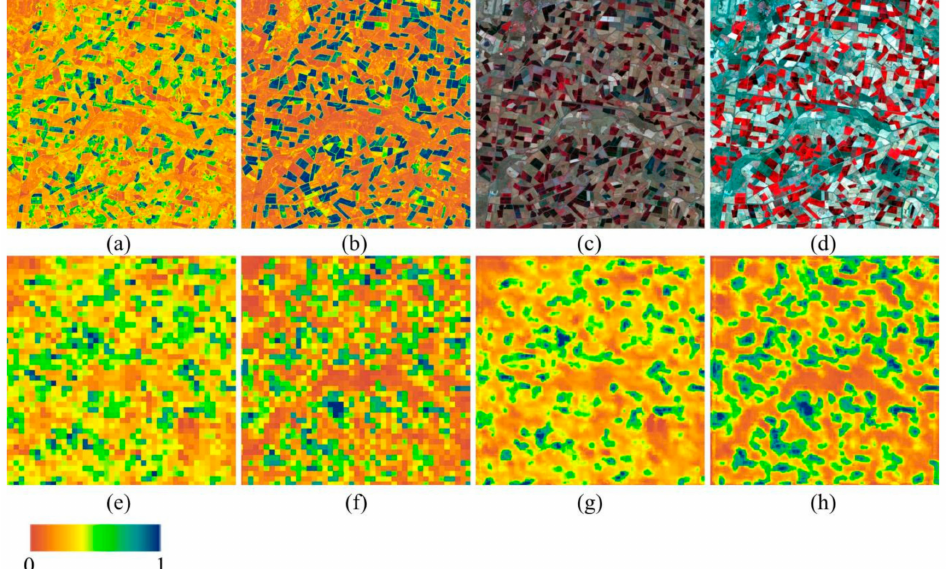
Figure 4. Test data at the Coleambally Irrigation Area: Landsat NDVI obtained on ( a ) 4 December 2001 and ( b ) 12 January 2002, Landsat false-color composite images obtained on ( c ) 4 December 2001 and ( d ) 12 January 2002, ( e , f ) resampled MODIS NDVI corresponding to the same dates, and ( g , h ) corrected MODIS NDVI corresponding to the same dates.